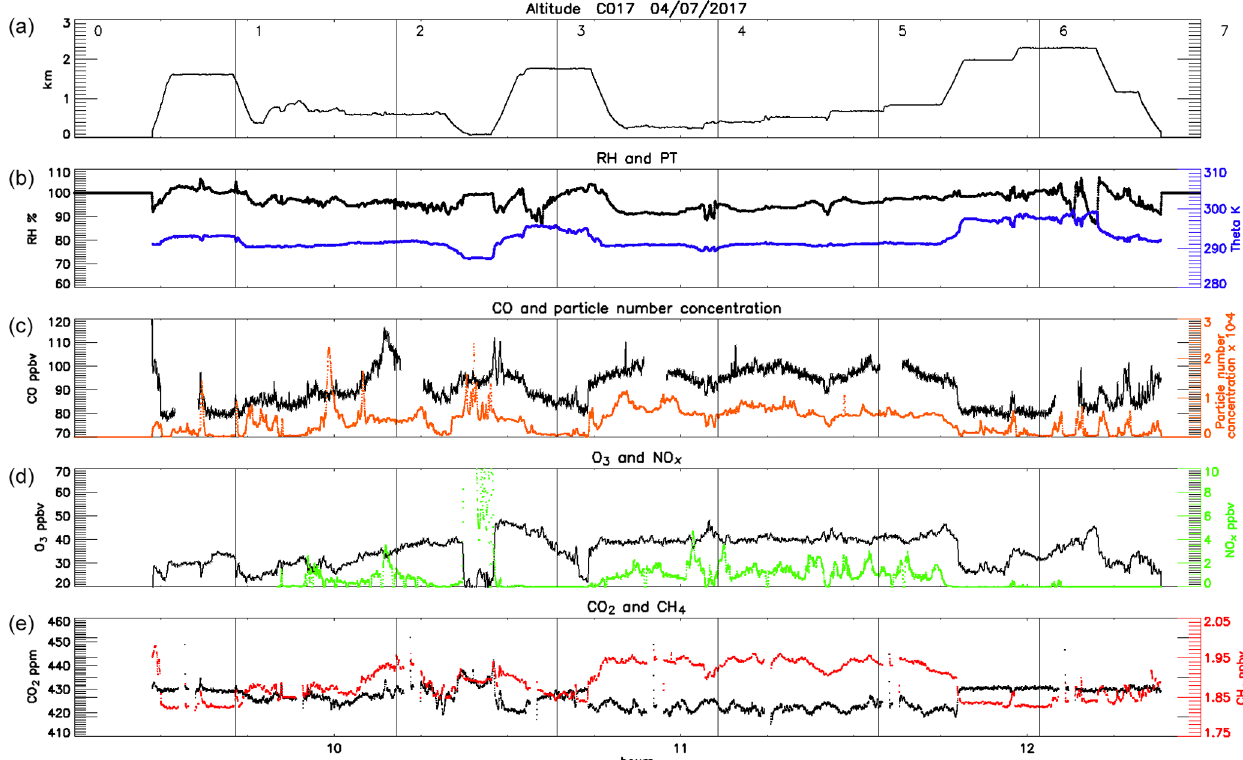
Figure 5. As in Fig. 4 but for the second flight (C017; 4 July,